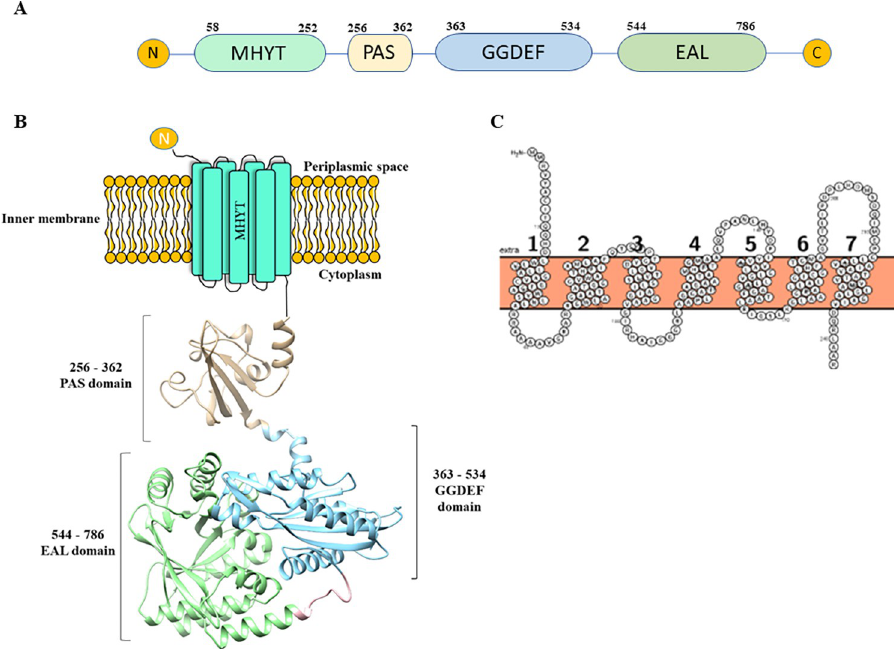
Fig 1. Structural architecture and homology modeling of CdgB protein of A . baldaniorum Sp245. (A) Schematic representation of the conserved domains of CdgB determined by the SMART database (http://smart.embl-heidelberg. de). (B) Transmembranal regions of CdgB analyzed with the Protter server. (C) Schematic representation of the 3D structure of the CdgB, PAS-GGDEF-EAL domains. The MHYT transmembrane domain was not integrated into the homology model, however, it is represented schematically into the cytoplasmic membrane cartoon. The PAS domain is in beige, the GGDEF domain is in blue, and the EAL domain is shown in green.